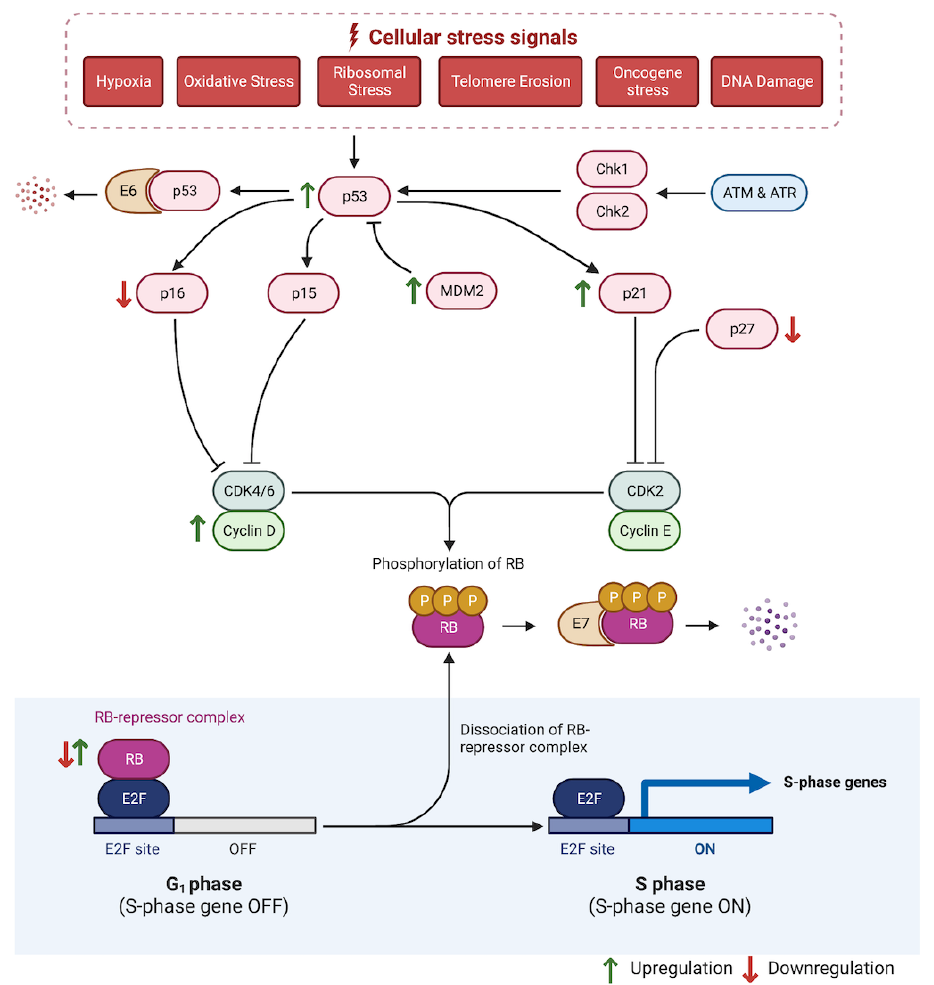
Figure 3. p53 tumor suppressor pathway. p53 acts on the G1/S checkpoint of the cell cycle to mediate cell cycle arrest via activation of CDK inhibitors. Arrows represent alterations in head and neck dysplasia. Adapted from “G1/S Checkpoint” and “The p53-Mediated Response,” by BioRender.com (2022) (https://app.biorender.com/biorender-templates (accessed on 10 August 2022)).